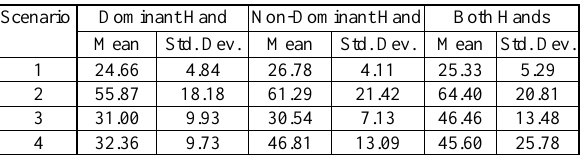
Figure 5. Fixation Number Differences Among Scenarios Wilcoxon signed-rank tests was conducted for under- standing the difficulty levels between scenarios under dominant-hand, non-dominant hand and both hands condi- tion with a Bonferroni correction (p < 0.017). The mean and standard deviation values for each scenario under dominant hand, non-dominant hand and both hands condi- tions are given at Table1. Table 1. Mean and Standard Deviation values for Fixation Number Scenario